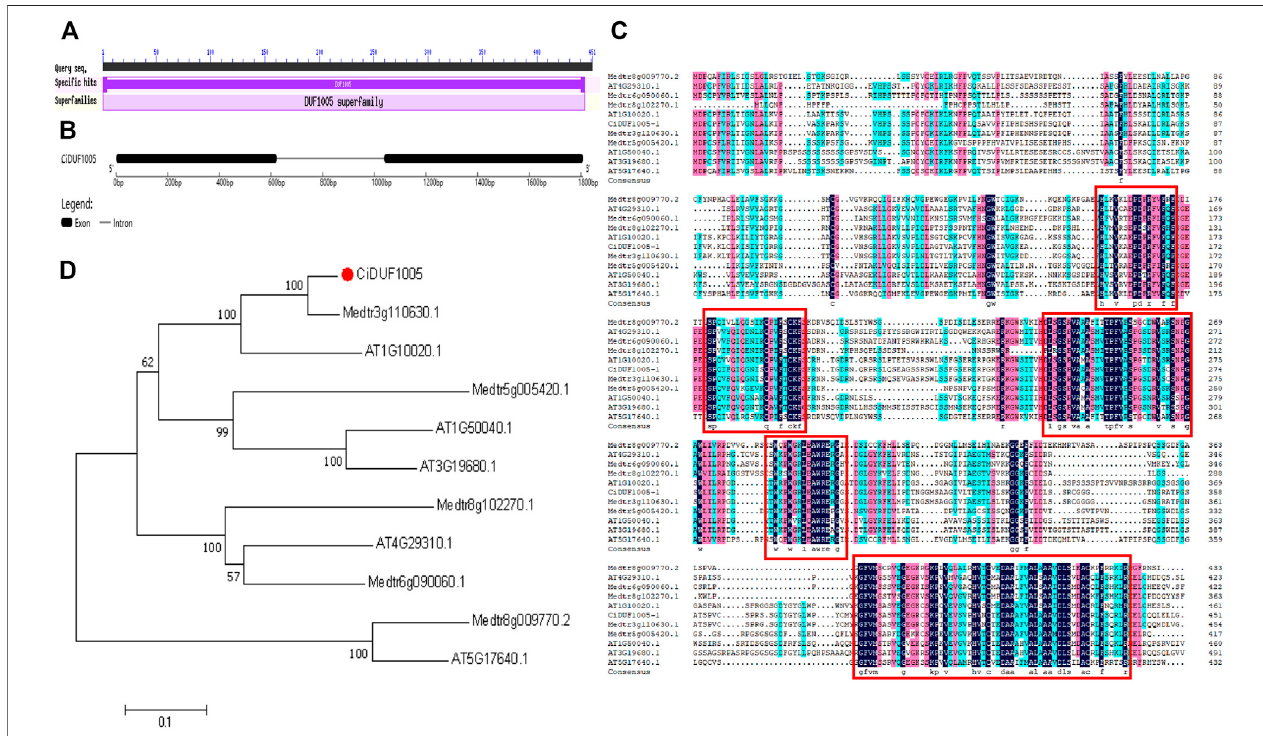
FIGURE4| BioinformaticsanalysisofDUF1005inplants. (A) ThedomainofCiDUF1005. (B) ThegenestructureofCiDUF1005. (C) Multiplesequencealignmentof CiDUF1005 and its homologs. The colors of the conserved residues represent different levels of conservation of each column in the alignment. The fi ve basically conserved areas are represented by red rectangles. (D) Phylogenetic tree analysis of CiDUF1005 and its homologs.